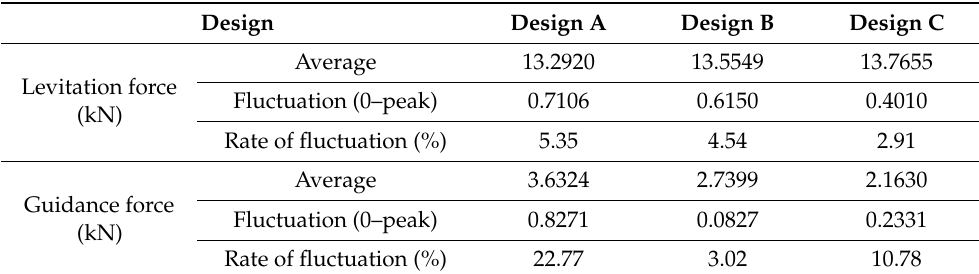
Table 3. Average value and fluctuation in levitation/guidance force.